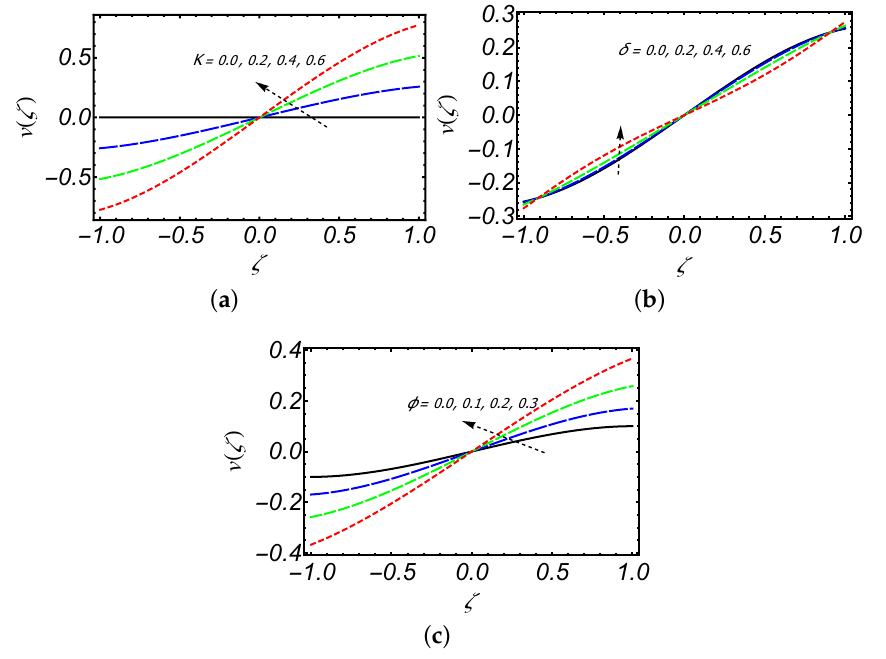
Figure 9. Behavior of v ( ζ ) with ( a ) K when φ = δ = 0.2, ( b ) δ when K = φ = 0.2, ( c ) δ when K = φ =